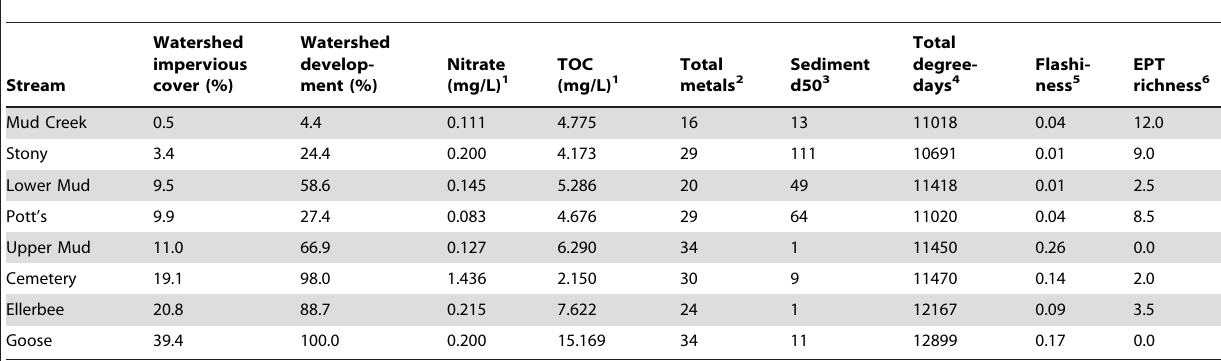
Table 1. Study streams, ranked in order of percent impervious cover in the watershed.